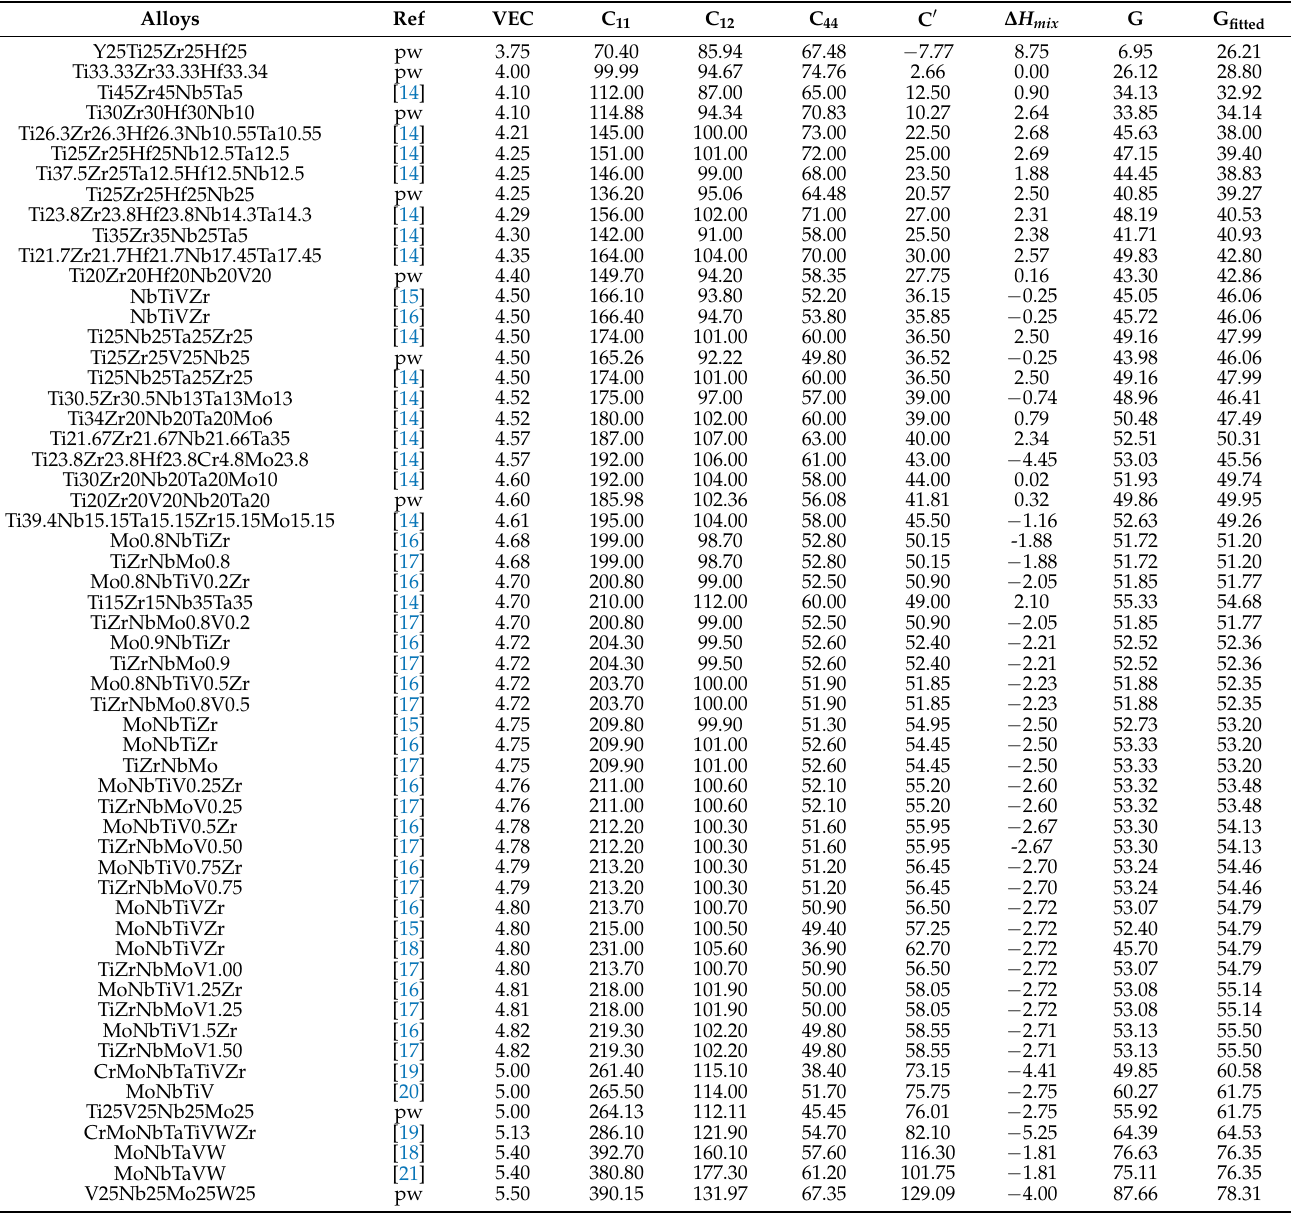
Table 1. Ab initio calculated elastic constants (in GPa), valence electron concentration, enthalpy of mixing (in kJ/mole), and shear modulus (in GPa) for the samples of the present work (pw) and those taken from the